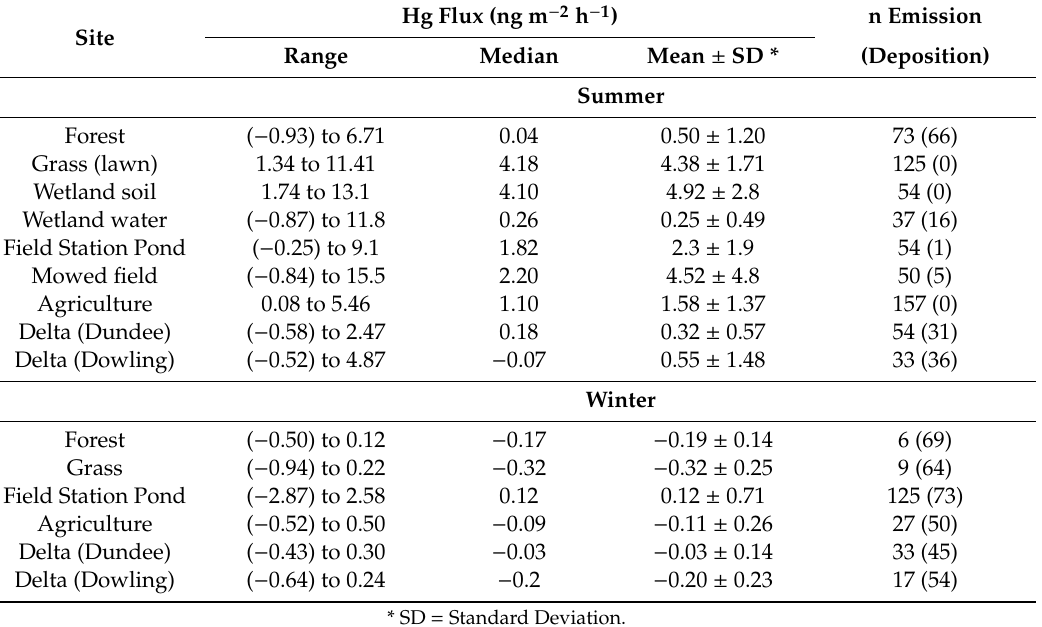
Table 3. Summary statistics for air / surface gaseous elemental mercury (GEM) exchange rates over landscapes in Mississippi.